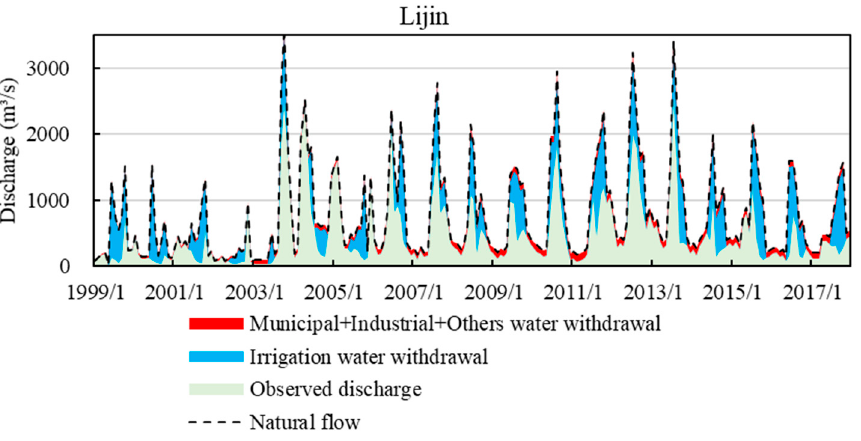
Figure 10. Monthly naturalized flow at Lijin station.